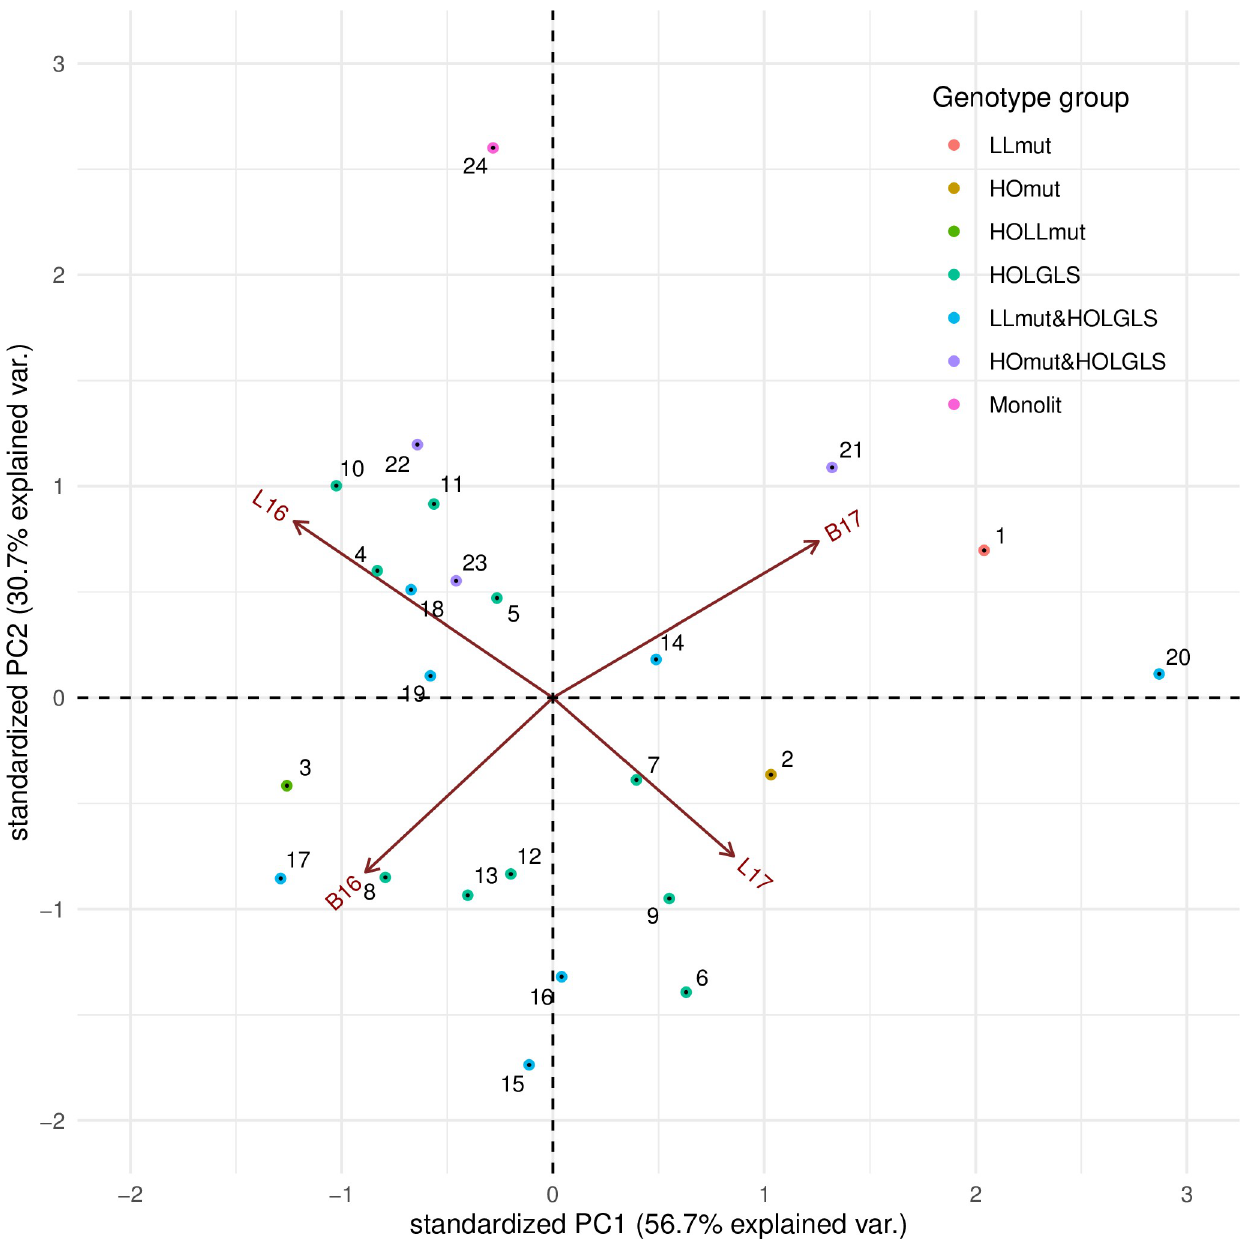
Fig 3. Biplot for G × E effect estimates of oleic acid content in genotypes in relation to the resultant environment. Genotypes are indicated by points and environments by lines. B—Borowo location; L—Lagiewniki location; 16–2015/2016 growing season; 17–2016/2017 growing season. HOLGLS domestic accessions 535 (ID9) and 561 (ID12) revealed significantly decreased trait value in B16 (against L16, L17 and B17). A group of genotypes revealed decreased trait value in L16. They were: the LLmut_681 genotype (ID3), three HOLGLS domestic accessions: geno- type 480 (ID4), 481 (ID5), 543 (ID10), the LLmut&HOLGLS_988 line (ID19), and two HOmut&HOLGLS genotypes 852 (ID22), and 873 (ID23), whereas for LLmut_681 genotype and for the HOmut&HOLGLS genotype_852 (ID22) the difference was significant. Interest- ingly, HOmut_10464, HOLGLS_519 (ID7), and HOmut&HOLGLS_850 (ID21) showed